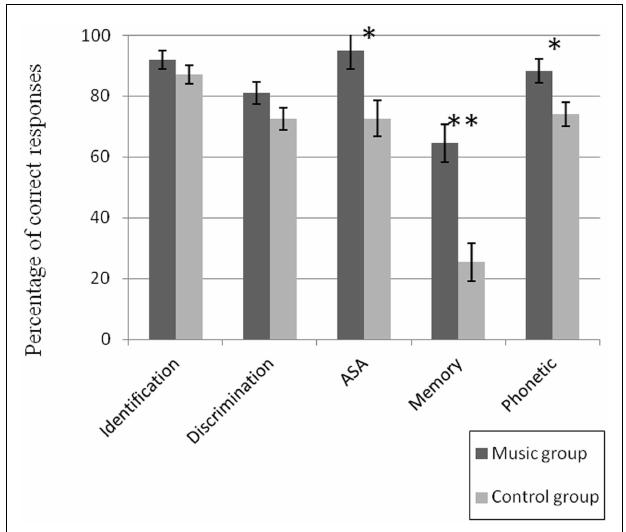
FIGURE 2 | Scores of auditory performance for the music and the control groups . Stars represent significant differences between groups: * p < 0.05, ** p < 0.01. Errors bars represent one standard